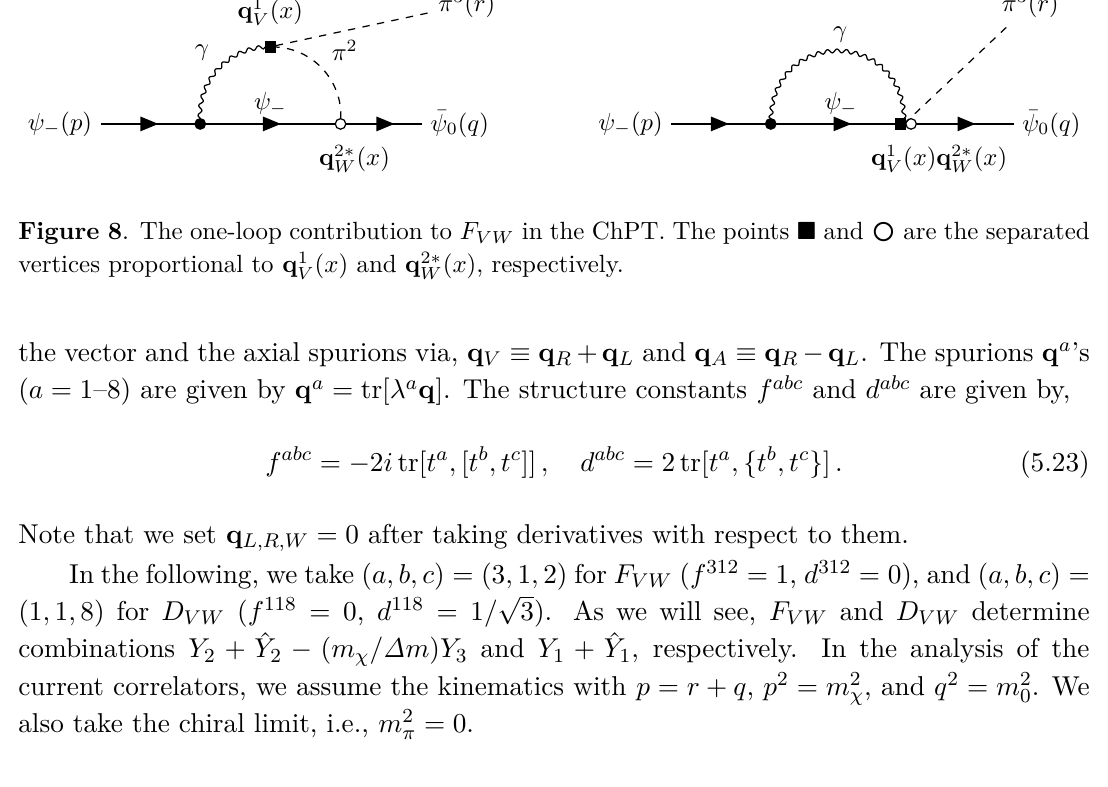
Figure 8 . The one-loop contribution to F V W in the ChPT. The points (cid:4) and vertices proportional to q 1